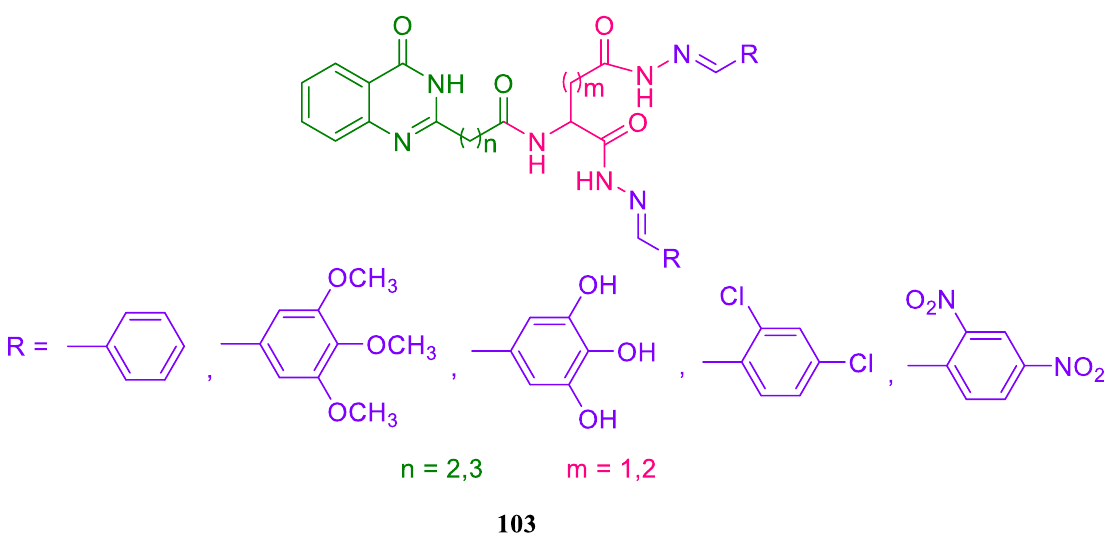
Figure 83. Amino acids (Glu and Asp) linked bis -hydrazones of quinazolinones.